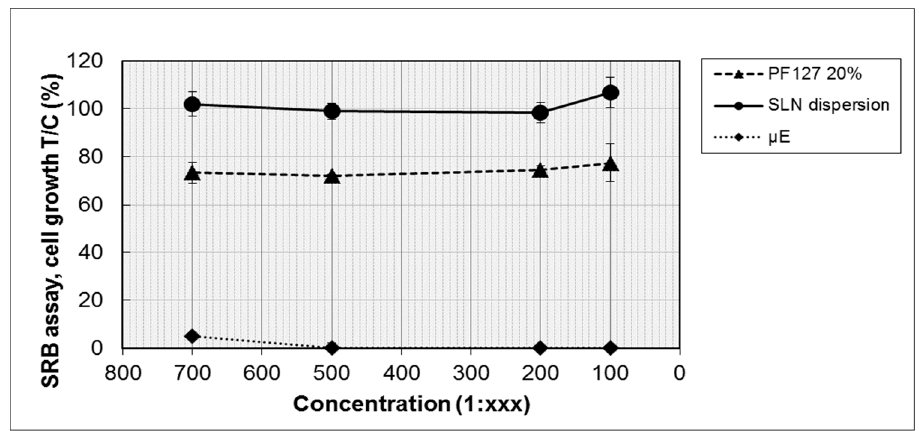
Figure 11. Effect of blank SLN dispersion, µE1 and PF127 20% w/v hydrogel on ARPE-19 cell Figure11. E ff ectofblankSLNdispersion, µ E1andPF12720% w / v hydrogelonARPE-19cellproliferation proliferation after 72 h of incubation. Cell growth is expressed as the % T/C (mean OD of treated after 72 h of incubation. Cell growth is expressed as the % T / C (mean OD of treated cells / mean OD of cells/mean OD of control cells × 100). Values are mean ± SD ( n = 3 wells/condition) of two independent control cells × 100). Values are mean ± SD ( n = 3 wells / condition) of two independent experiments.